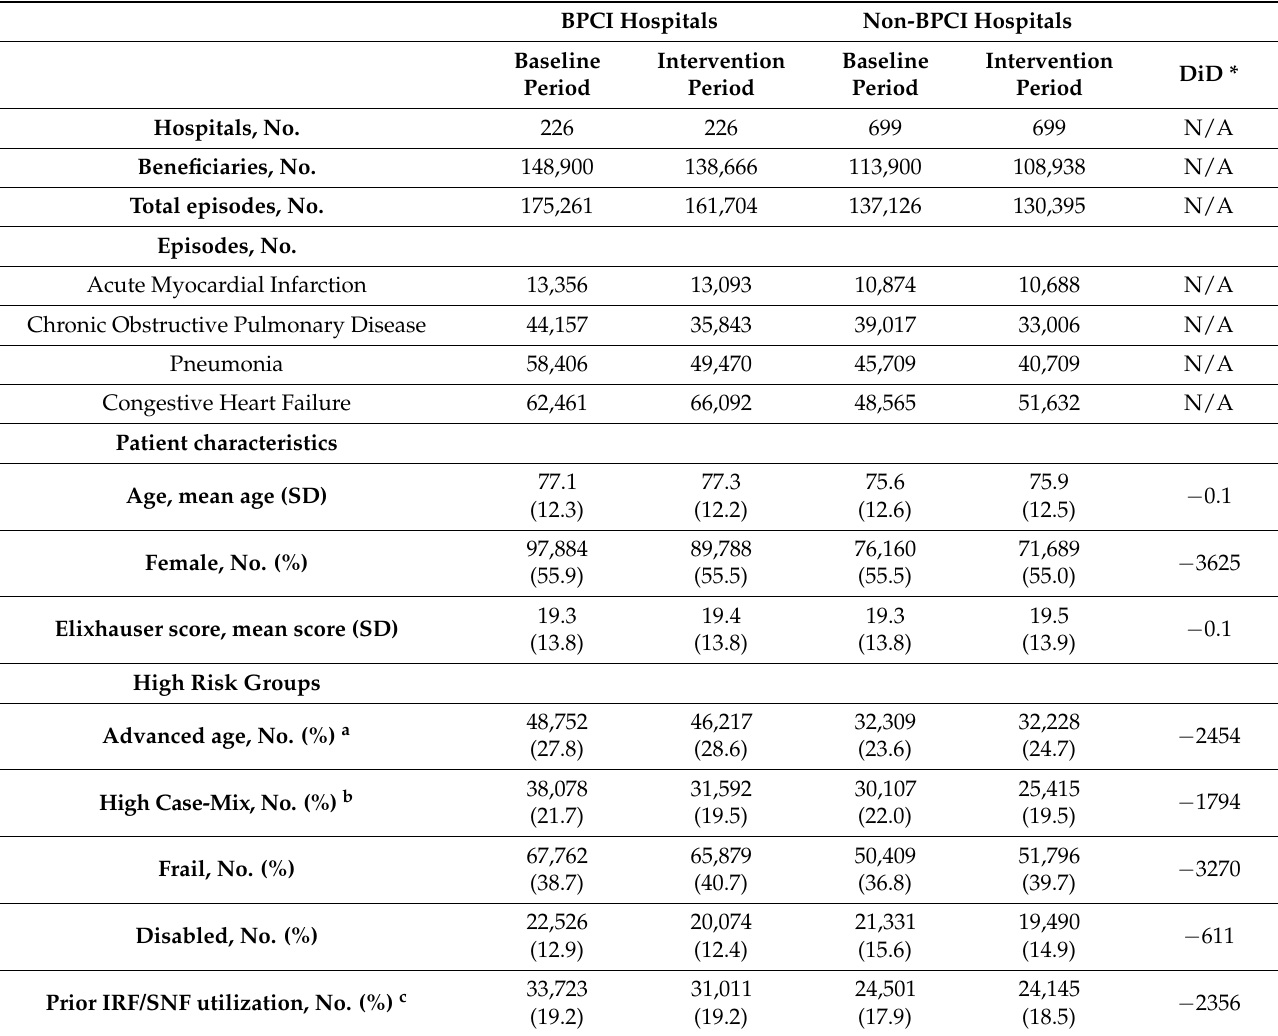
Table 2. Characteristics of Patients Hospitalized for Medical Condition Episodes to BPCI and Non- BPCI Hospitals (2011–2016). BPCI Hospitals Non-BPCI Hospitals Baseline Intervention Baseline Intervention Period Period Period